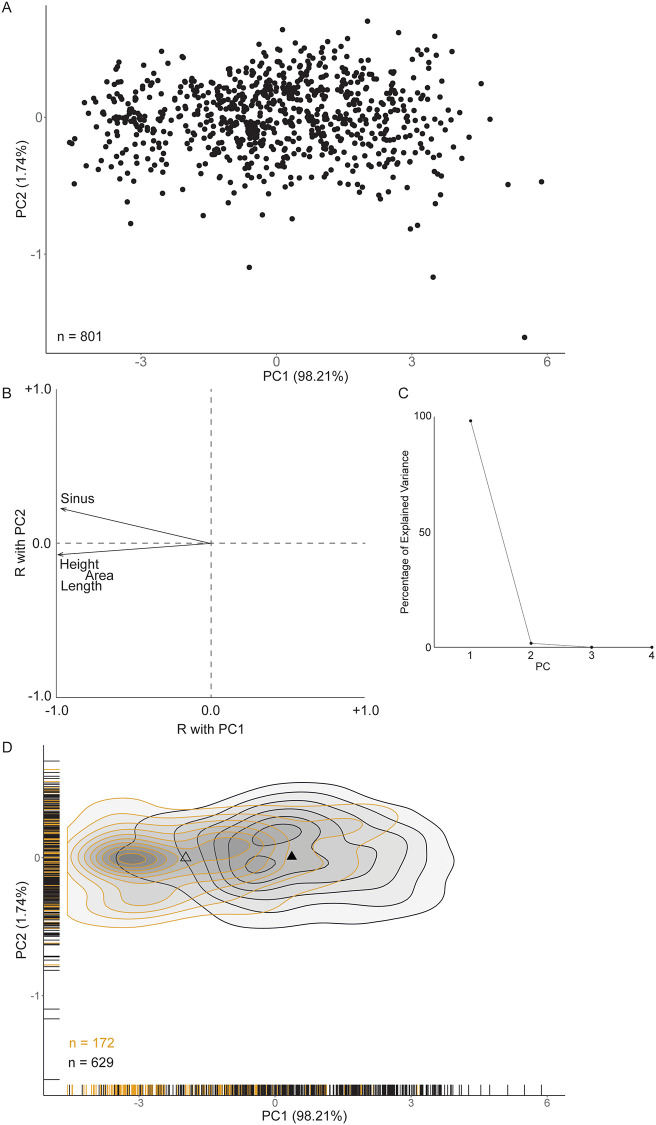
Principal Components Analysis of whole Holocene C. gallina from the Po coastal plain, Italy.A) PC1 vs PC2 (n = 801). B) Loadings plot. Values are Pearson correlation coefficients between PC1/PC2 and valve length, height, area, and pallial sinus depth. C) Scree plot relating principal components and the amount of variation explained. D) Two-dimensional density and rug plots of PC1 v PC2 by infected (yellow) and uninfected (black) valves. The triangles (hollow = infected, solid = uninfected) indicate median PC1 and PC2 values.